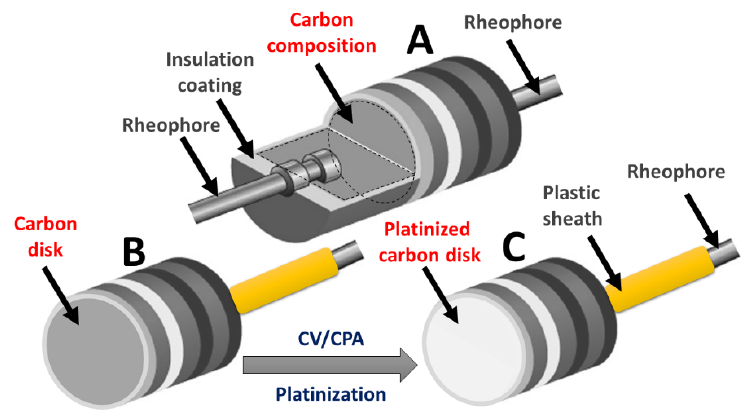
Figure 1. Scheme of the construction of the sensors obtained from the carbon-composition resistors (CCRs). A: schematic representation of the resistor; the rheophores are connected by a conductive carbonaceous composite enclosed within an insulating jacket; B: carbon disk (1.25 mm Ø) obtained by cutting the resistor in a half, the insulating plastic sheath is in yellow; C: carbon disk platinized via CV or via